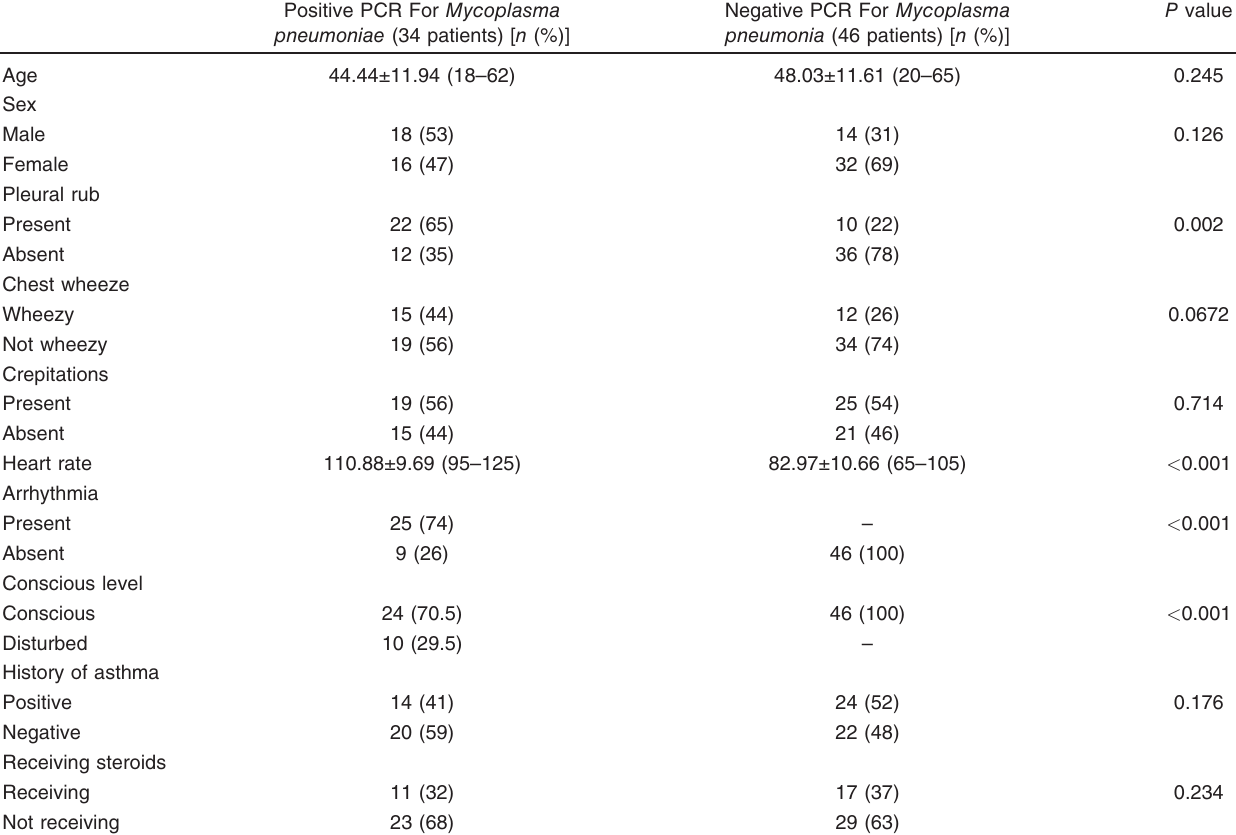
Table 3 Distribution of demographic and clinical characters in relation to PCR results Positive PCR For Mycoplasma pneumoniae (34 patients) [ n